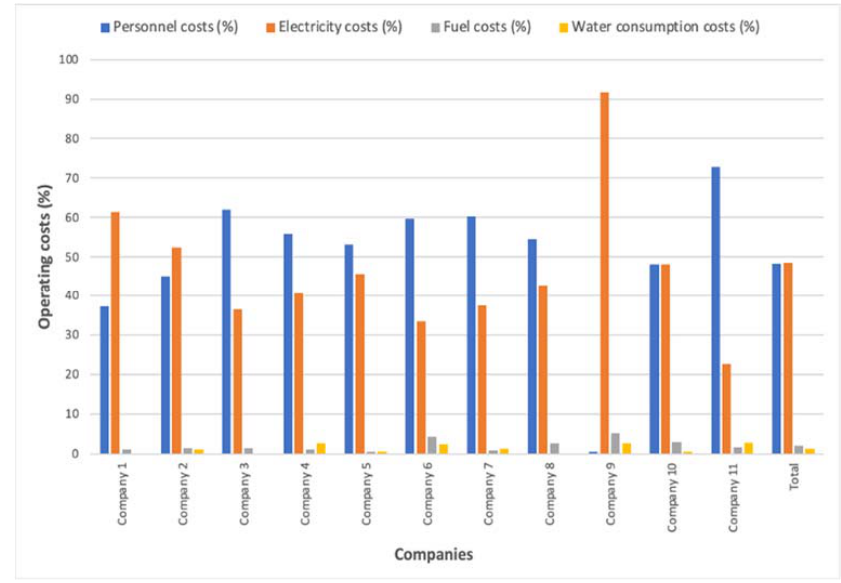
Figure 2. O perating costs for the 11 Portuguese wastewater management companies. Figure 2. Operating costs for the 11 Portuguese wastewater management